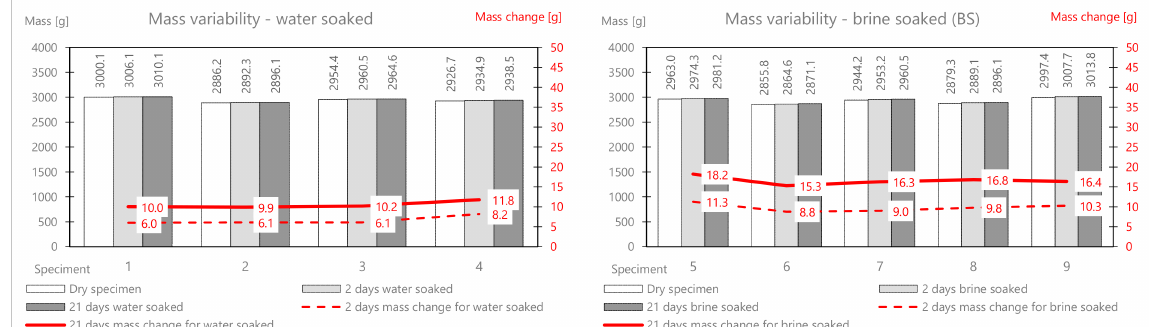
Figure 5. AC11S mix mass